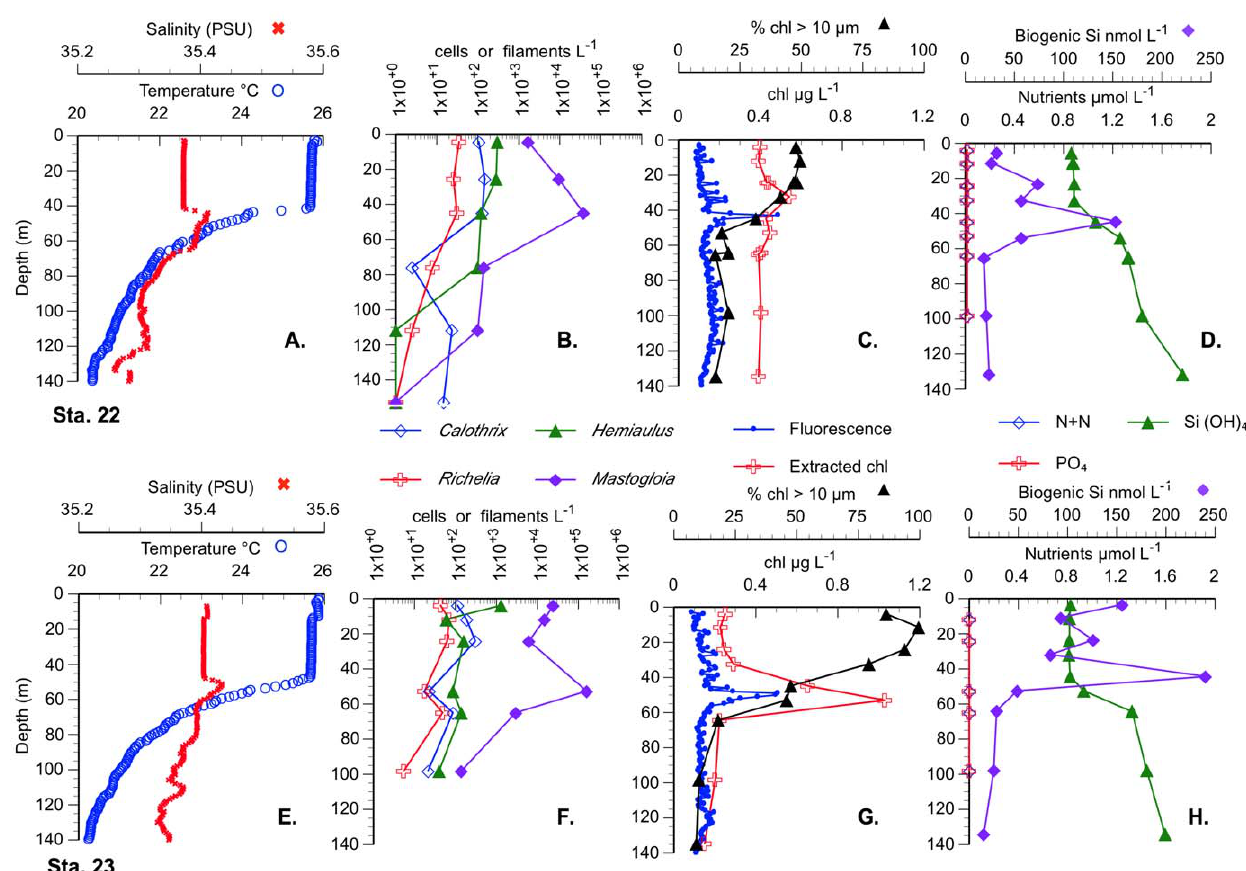
Figure 6. Station 22 (A-D) and 23 (E-H) on 12 Aug. 2009. A, E. Temperature and Salinity CTD profiles. B, F. Cell and symbiont abundance. C., G. Chl a values. D., H. Nutrient and biogenic silica concentrations.